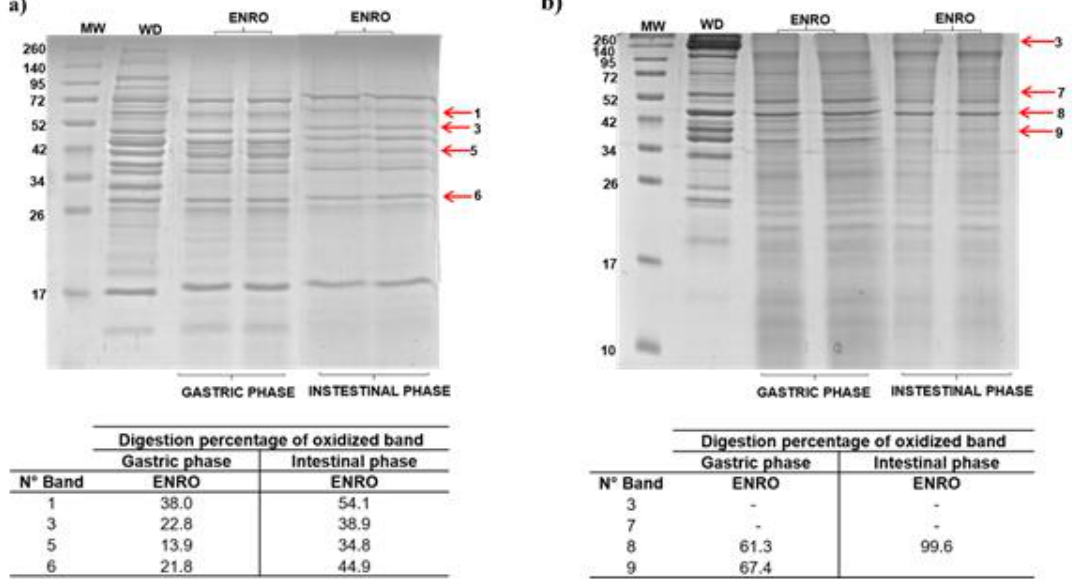
Figure 7. In vitro gastrointestinal digestion of beef proteins treated with enrofloxacin at 1.0 MRL. ( a ) sarcoplasmic and ( b ) myofibrillar proteins extracted treated samples subjected to gastric and intestinal digestion. The digestion electrophoretic profile was realized in 15% SDS-PAGE. Arrows indicate oxidized bands selected for the follow-up of their digestion. Tables show the digestion percentage of bands in gastric and intestinal phases. MW: molecular marker; WD: protein not digested.